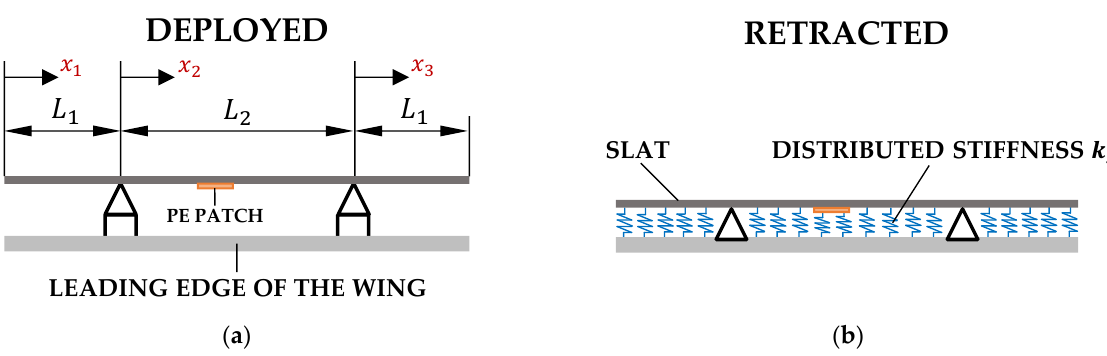
Figure 1. ( a ) Scheme of the deployed slat; ( b ) scheme of the retracted slat.